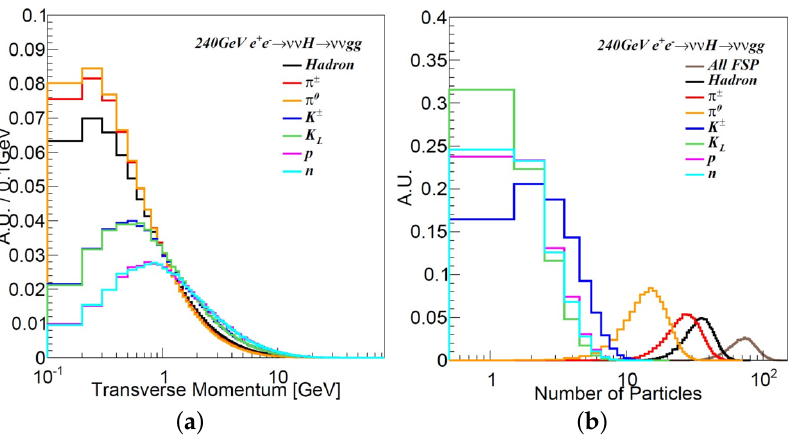
Figure 1. Jet components of the e + e − → νν H → ¯ νν gg at 240 GeV with distributions of ( a ) transverse momenta and ( b ) the number of different particles within a